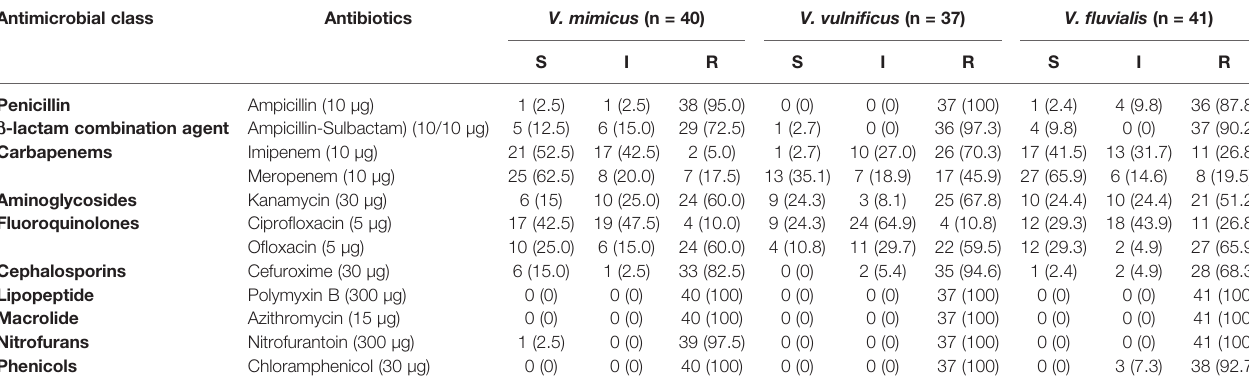
TABLE 3 | Distribution of antimicrobial susceptibility of Vibrio species recovered in all sampling sites. Antimicrobial class Antibiotics V. mimicus (n = 40) V. vulni fi cus (n = 37) V. fl uvialis (n =